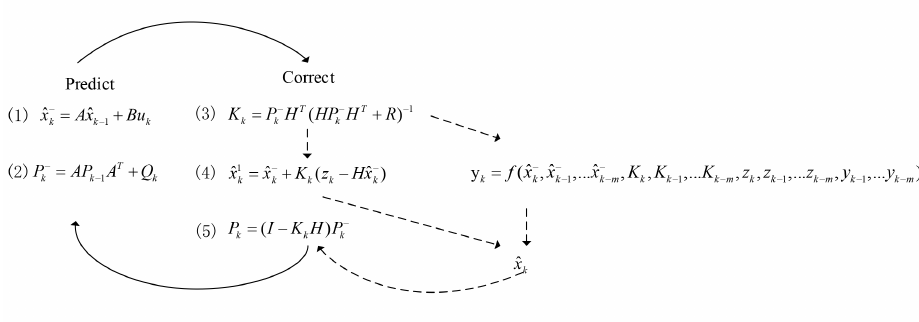
Figure 2. The structure of the combination of NARX model and Kalman Filter